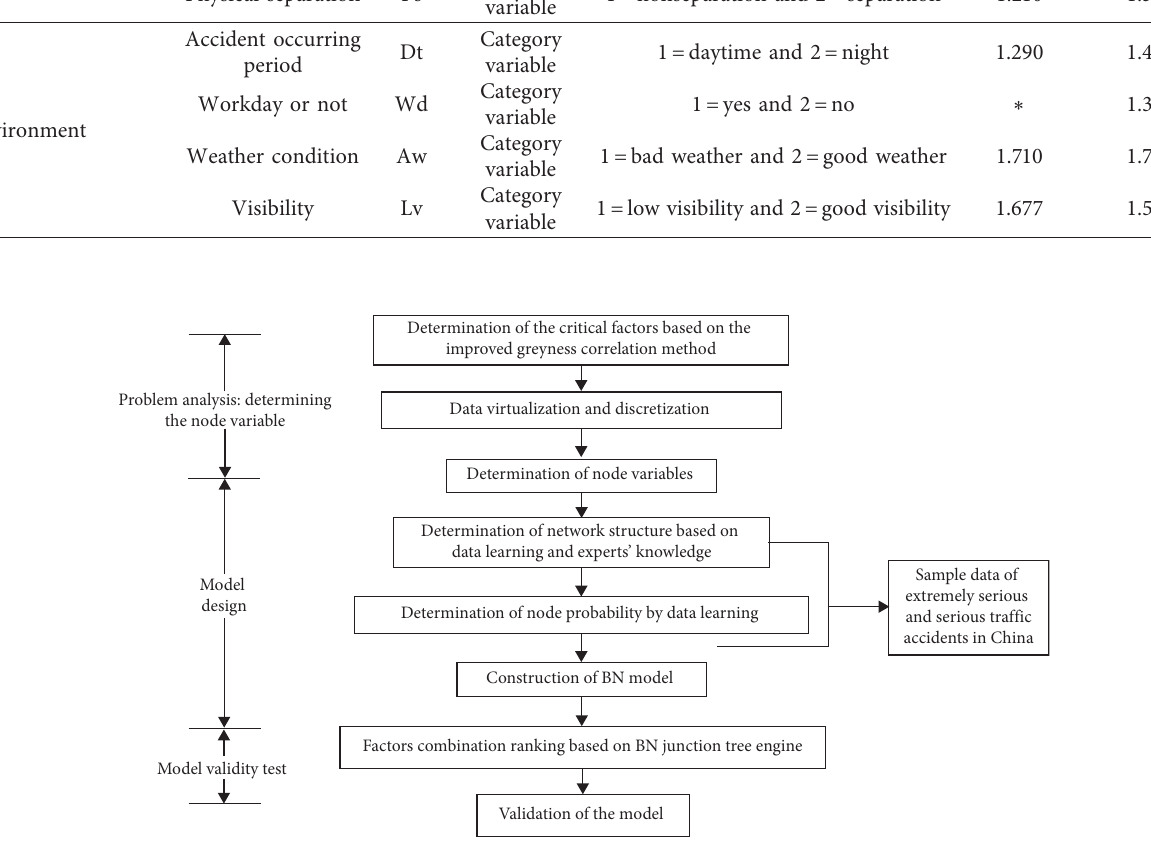
Figure 1: The flowchart of BN model